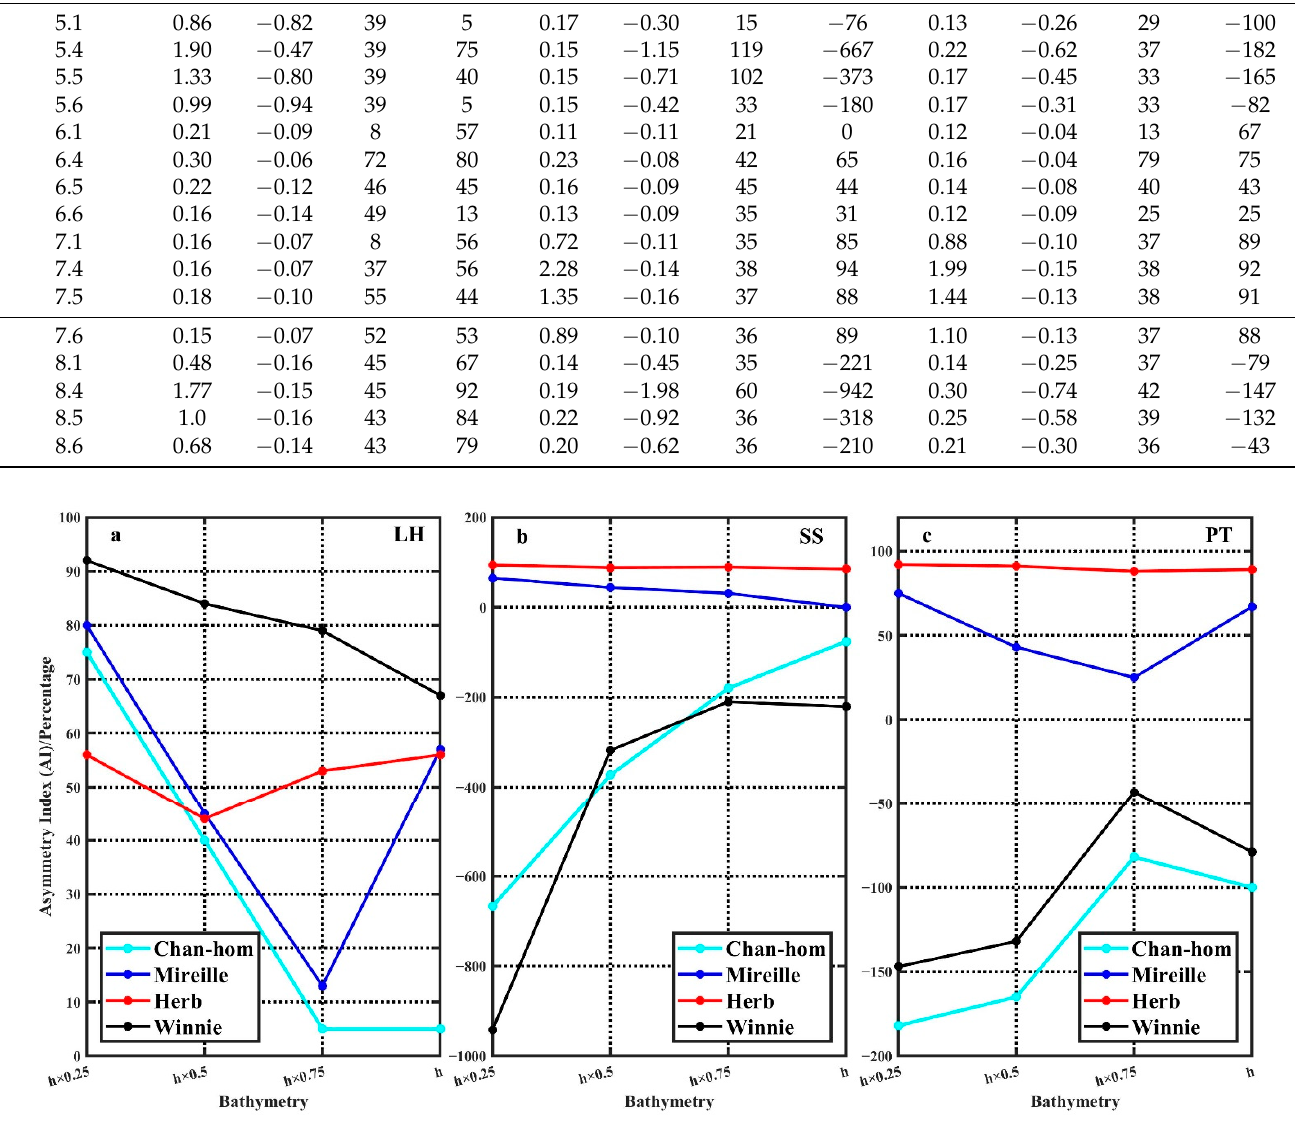
Figure 22. The relationship between asymmetry index and bathymetry during four paths simulations at: ( a ) LH, ( b ) SS, and ( c ) PT station.